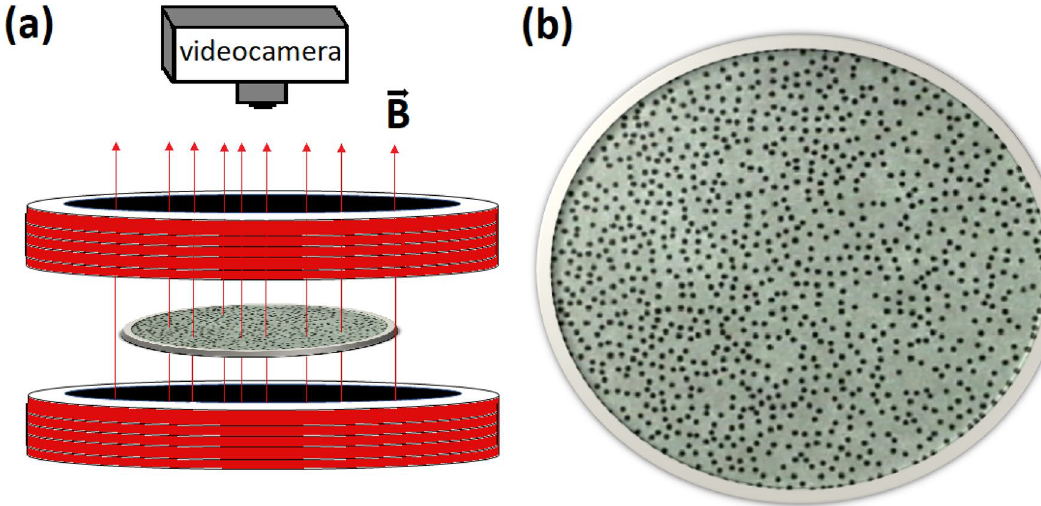
Figure 6. ( a ) Scheme of the experimental setup. The direction of the vertical sinusoidal magnetic field, B , is along the z -direction, while x and y are the horizontal directions where the particles move. ( b ) Particles on the glass